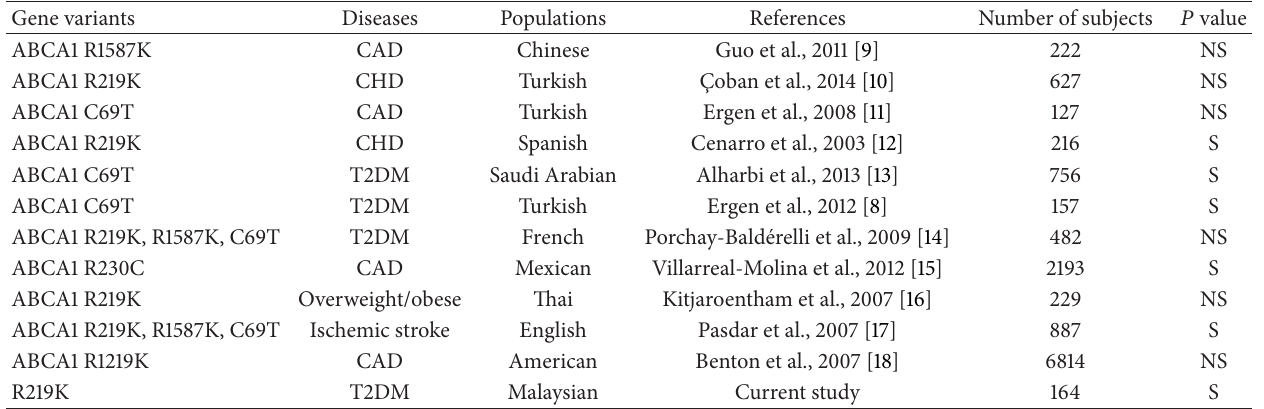
Table 6: Conflicting results of genetic variants found in different